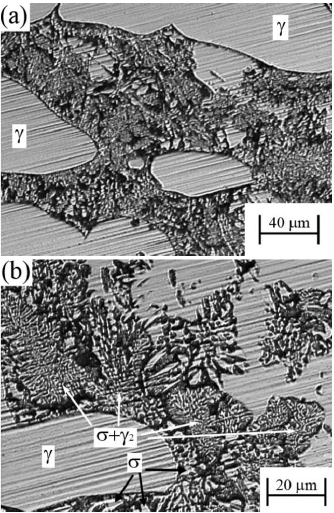
Figure 9. Microstructures observed after DL-EPR tests in SD-A aged at 850 °C for 60 min.